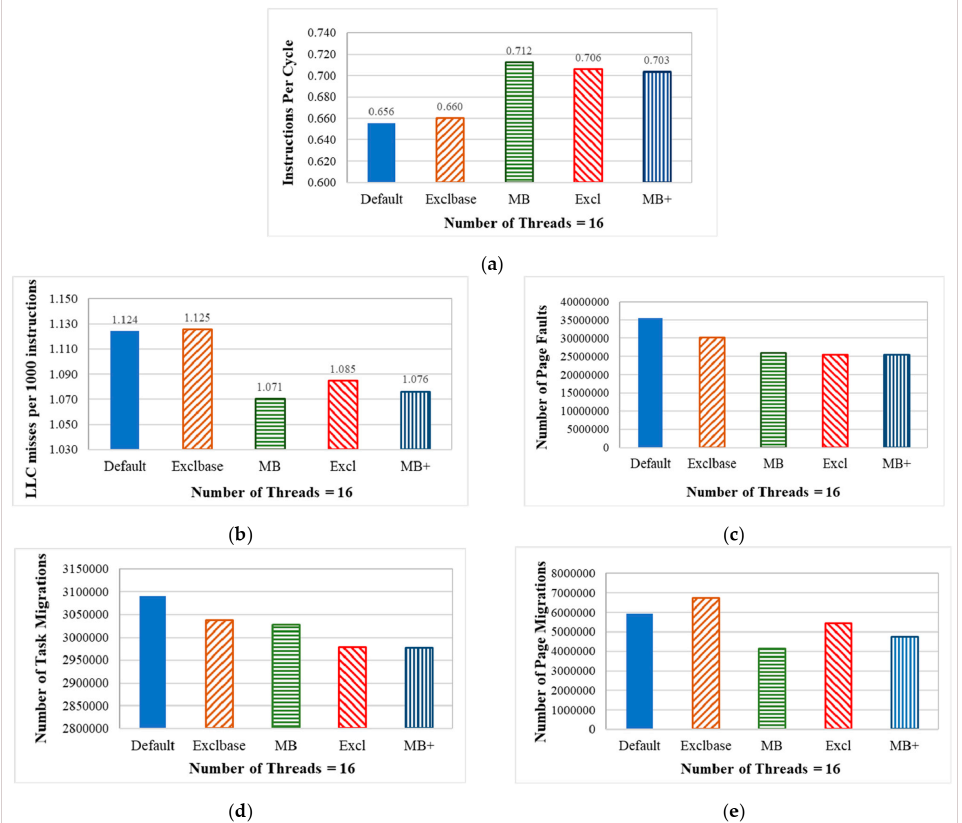
Figure 13. Experimental results for systems using different policies. ( a ) Instructions per CPU cycle; ( b ) LLC misses per 1000 instructions; ( c ) The number of page faults; ( d ) The number of tasks that are migrated; ( e ) The number of pages that are